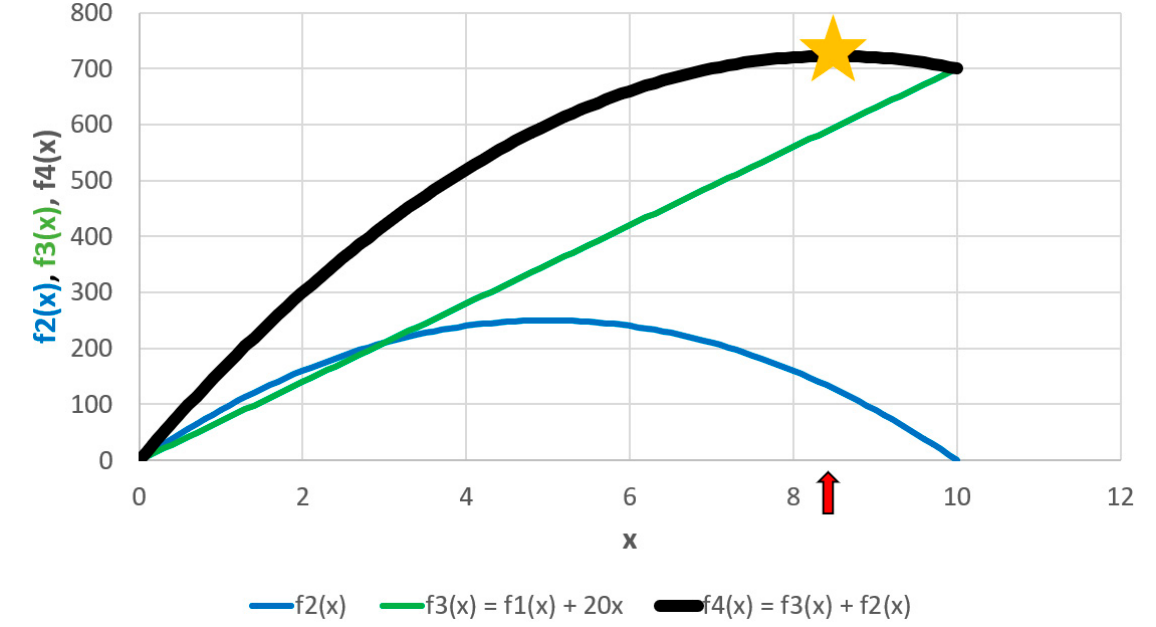
Figure 7. If the value per area unit of the free GREEN territory increases, by 40%, the optimal location of the war front moves to the east.